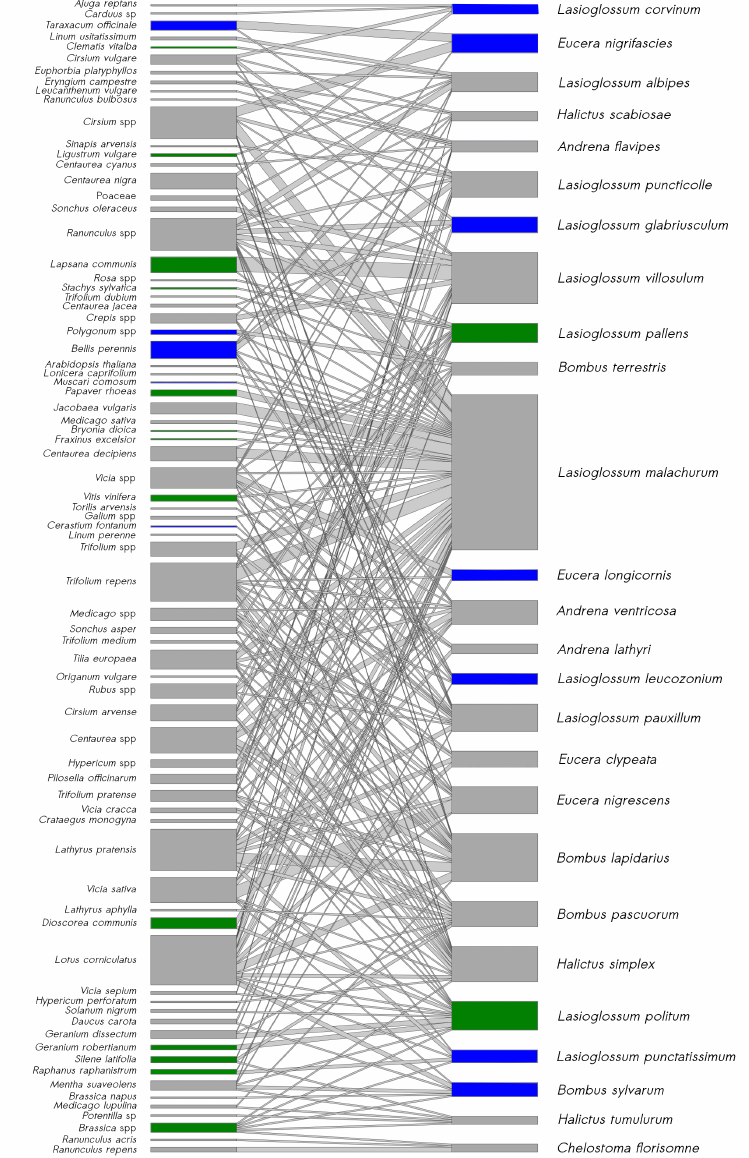
Figure 7. Bipartite graph of the bee–pollen interaction network containing the most abundant species in this study (>4 individuals). The width of the link indicates the frequency of the interaction. Blue bars represent species found only in grasslands; green bars represent species that were found in wooded SNH (i.e., hedgerows and/or forest